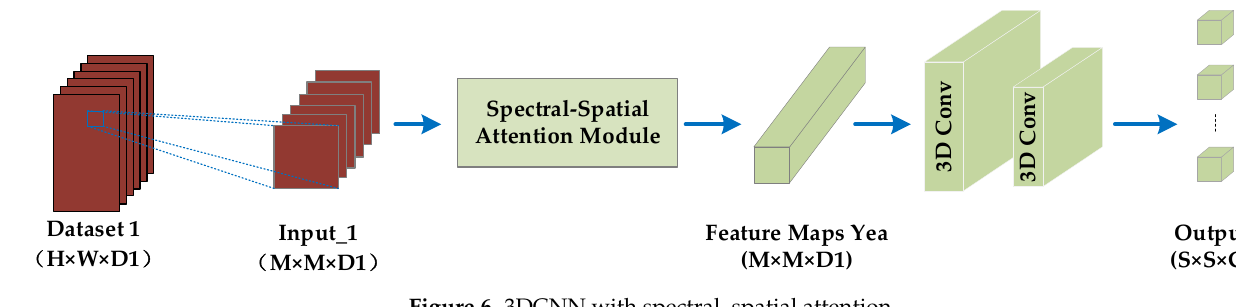
Figure 6. 3DCNN with spectral–spatial attention.